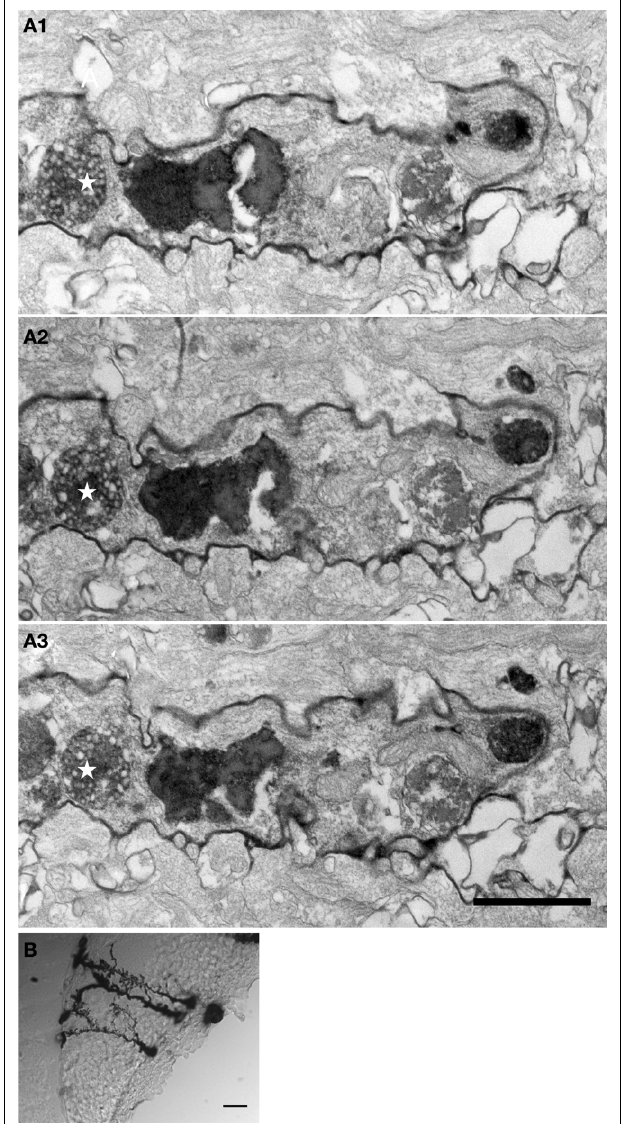
FIGURE 4 | mHRP labels the plasma membrane and endocytosed membrane of glial cells. (A –A ) Micrographs from serial EM sections show 1 3 the ultrastructure of processes from an mHRP-labeled radial glial cell. Labeled multivesicular organelles are marked as stars. (B) Vibratome section (60 µm) showing mHRP-labeled radial glial cells in the optic tectum. Scale bar: 20 µm in (A A ) , 1 µm in (B) 1 3